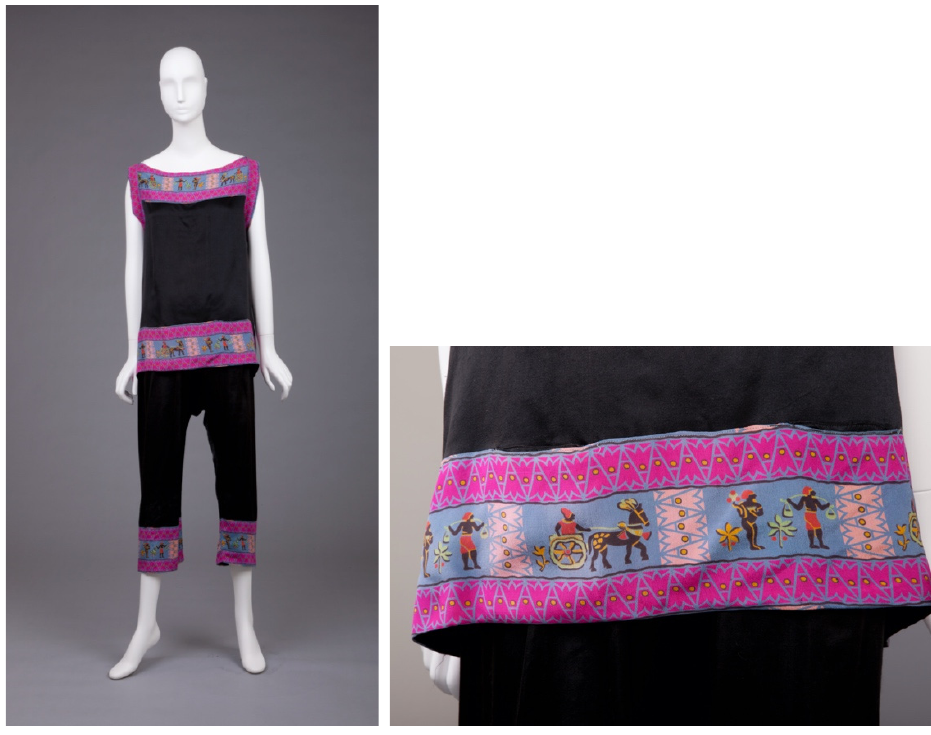
Figure 2. Unknown designer, c. 1920–1929, Goldstein Museum of Design (1994.007.019). Women’s black silk pajama top and bottoms with Egyptian motif silk at yoke and cuffs of bottoms. (From the Collection of the Goldstein Museum of Design, Gift of Felice Wender).